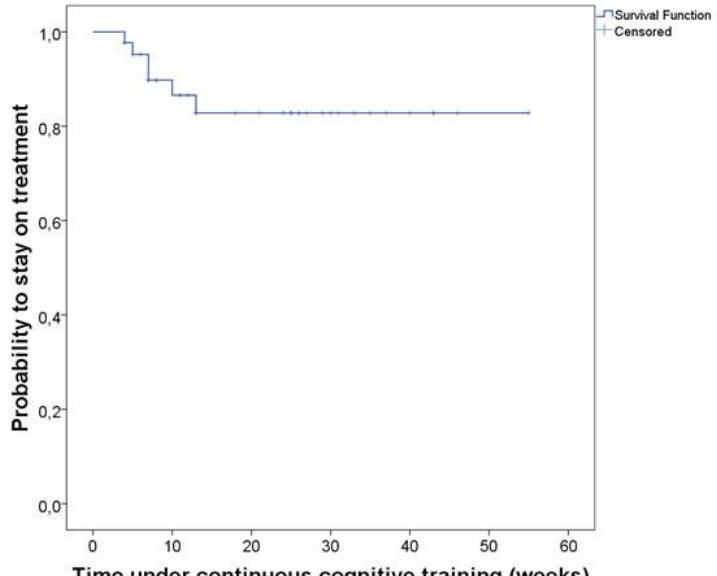
Figure 3. Probability of continuing with treatment over time (Kaplan-Meier survival function) for the first 60 weeks. There were no treatment interruptions